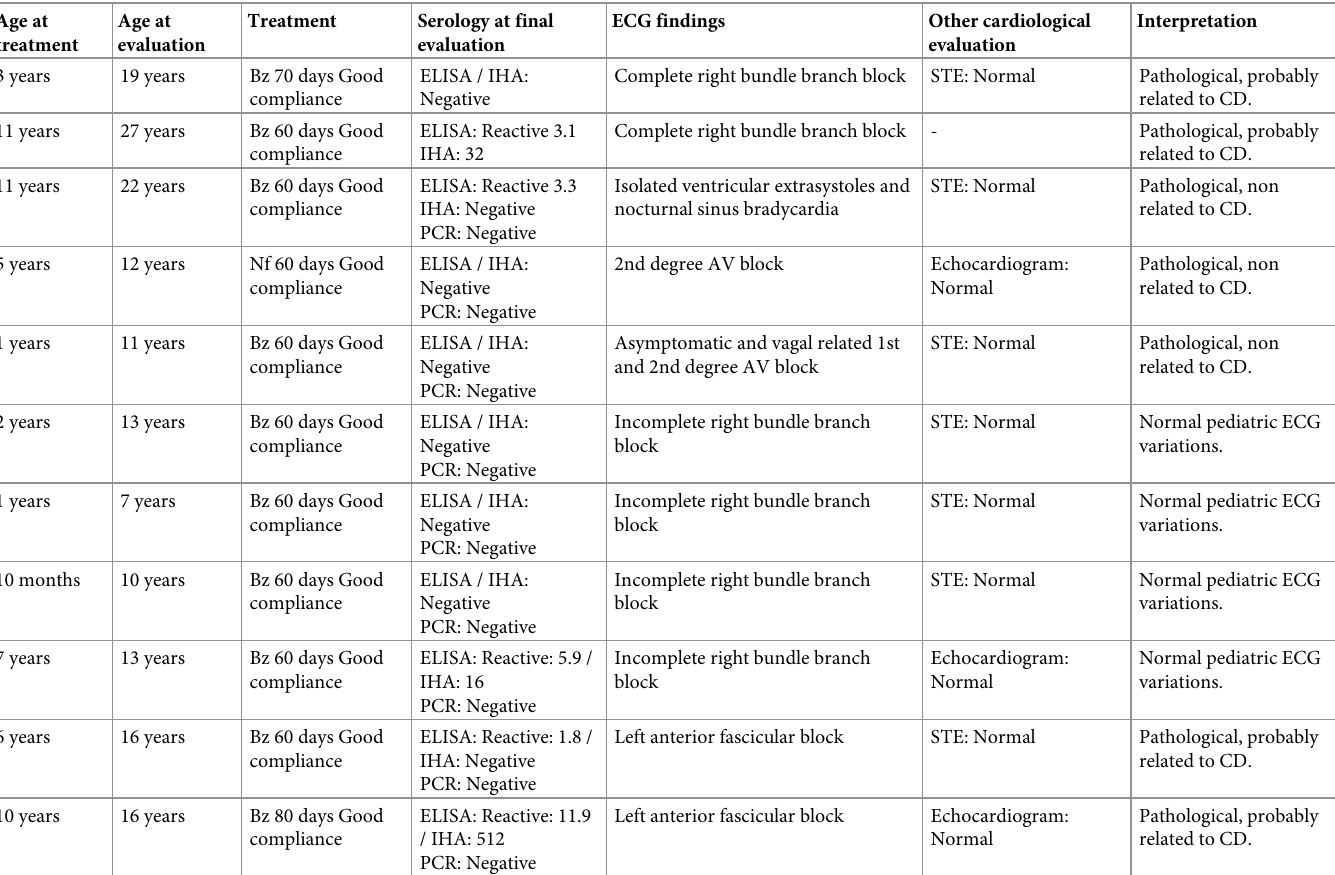
Table 1. Description of patients with ECG